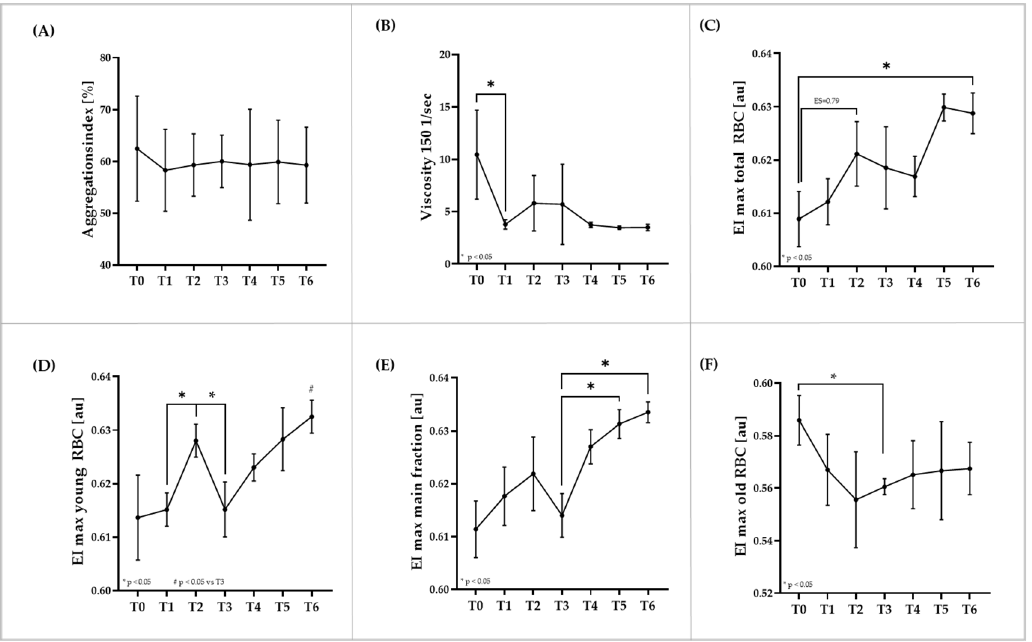
Figure 3. Changes of rheological parameters due to blood sampling and transfusion . ( A ) The aggregation index was not affected during the study period. ( B ) RBC viscosity decreased from T0 to T1 and remained at this reduced level throughout the remaining study period. Maximum deformability (EImax) of ( C ) total RBC increased throughout the study period, and of ( D ) young RBC increased during blood sampling (from T0 to T2) and from T3 after transfusion to T6. ( E ) EImax of main fraction RBC increased after blood transfusion. ( F ) In contrast, EImax of old RBC decreased throughout the blood sampling period (until T2) and remained reduced after transfusion. Data are mean (SD).